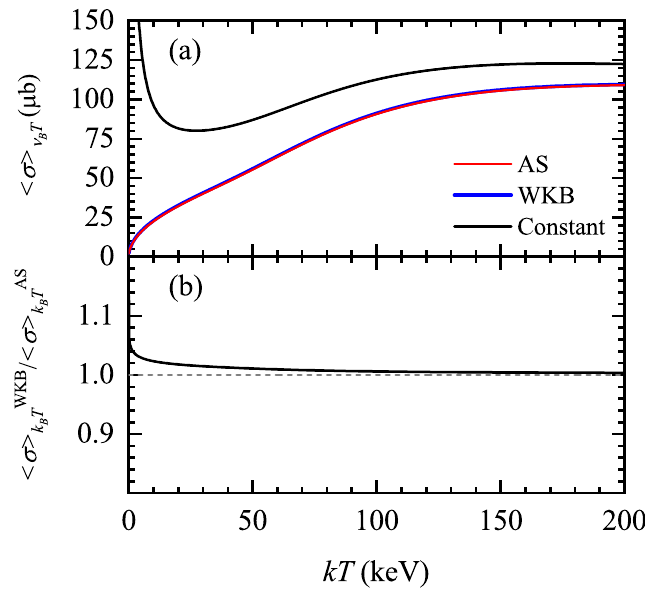
Figure 3. (a) MACSs for 16 O( n ,γ ) 17 O based on three decay widths: constant (black dashed line), Γ WKB (blue line), and Γ AS (red line), respectively. (b) ratio of < σ > WKB l